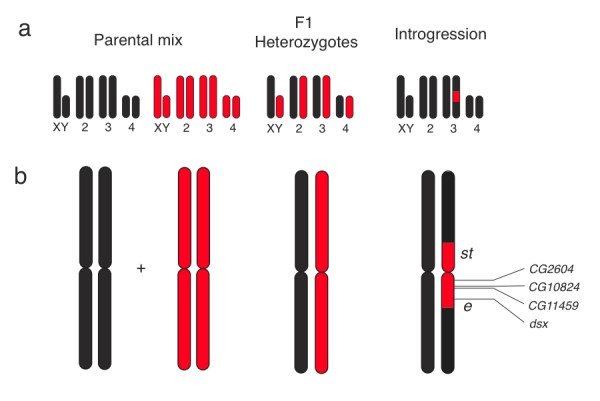
Nucleic acid samples. The three nucleic acid sample types used in this study: the parental mix, F1 heterozygote, and introgression lines. (a) Representation of all chromosomes for each genetic background assayed. Red represents the W line and black represents the tester line. (b) Zoom-in of chromosome 3 for each genotype. All genes analyzed are between the genetic markers scarlet (st) and ebony (e).